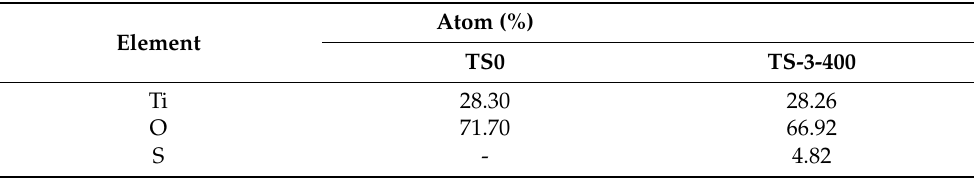
Table 4. Characterization of catalysts TS0 and